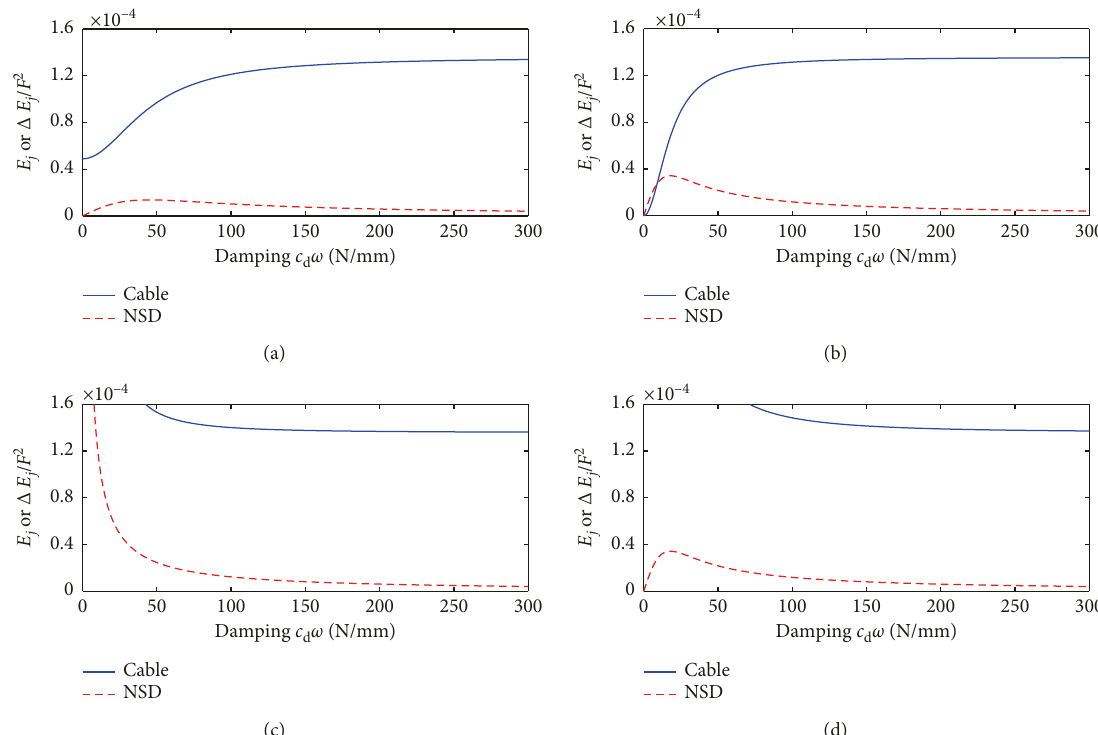
Figure 13: Change trend of the cable mechanical energy or the energy dissipated by the NSD to the damping with different levels of stiffness: � 2 k opt � k opt � 0; (d) k � | k opt | ; (b) k ; (c) k (a) k d d d d d d d